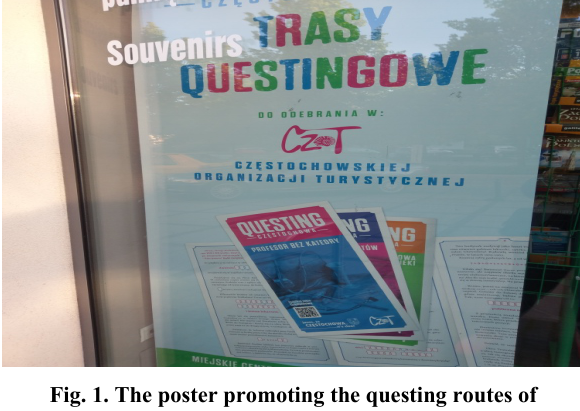
Fig. 1. The poster promoting the questing routes of Częstochowa in the shop window of Częstochowska Organizacja Turystyczna (Tourist Organization of Częstochowa)